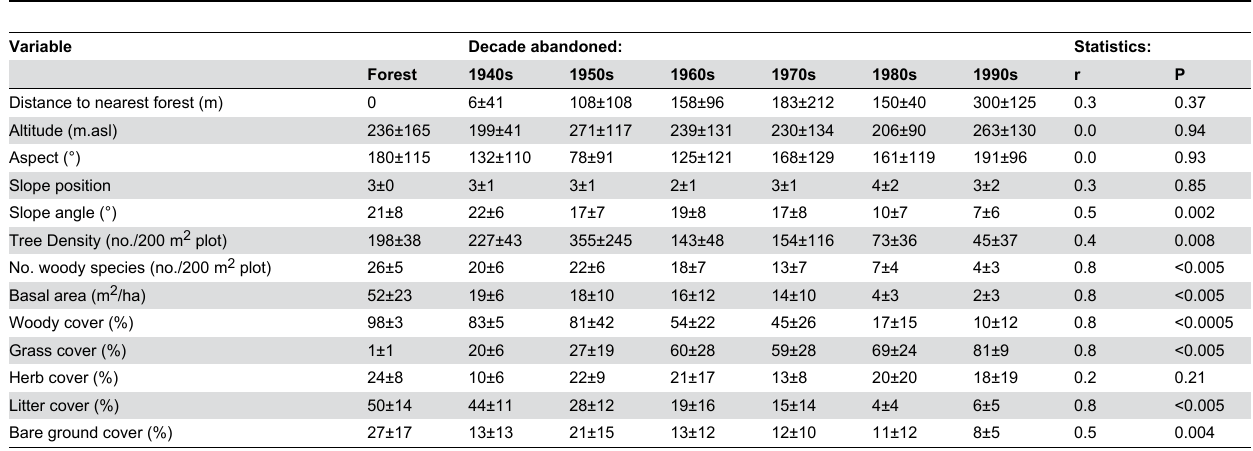
Table 1. Physical and vegetation attributes (mean + SE) of uncleared forests and fields with different lengths of abandonment (N = 55).